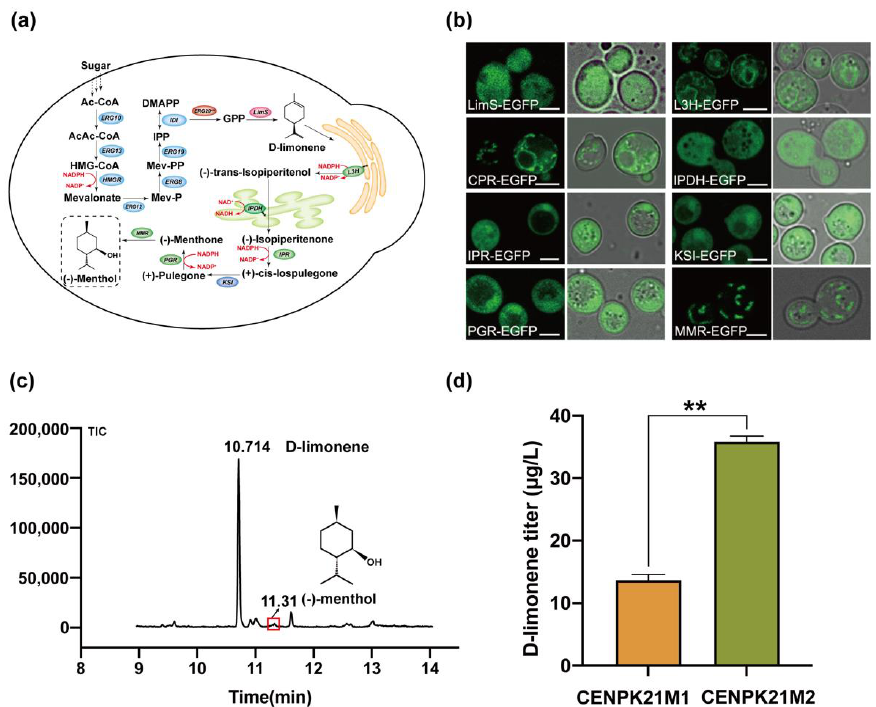
Figure 1. Schematic of pathway remodeling and compartmentalization of D-limonene and ( − )- menthol: ( a ) illustration of the ( − )-menthol biosynthesis pathways in S. cerevisiae ; ( b ) subcellular localization of the eight genes involved in ( − )-menthol biosynthesis; ( c ) GC–MS diagrams of D- limonene and ( − )-menthol; and ( d ) titer of the intermediate product D-limonene in the CENPK21M1 and CENPK21M2 strains (Statistical significance is indicated as ** for p < 0.01).